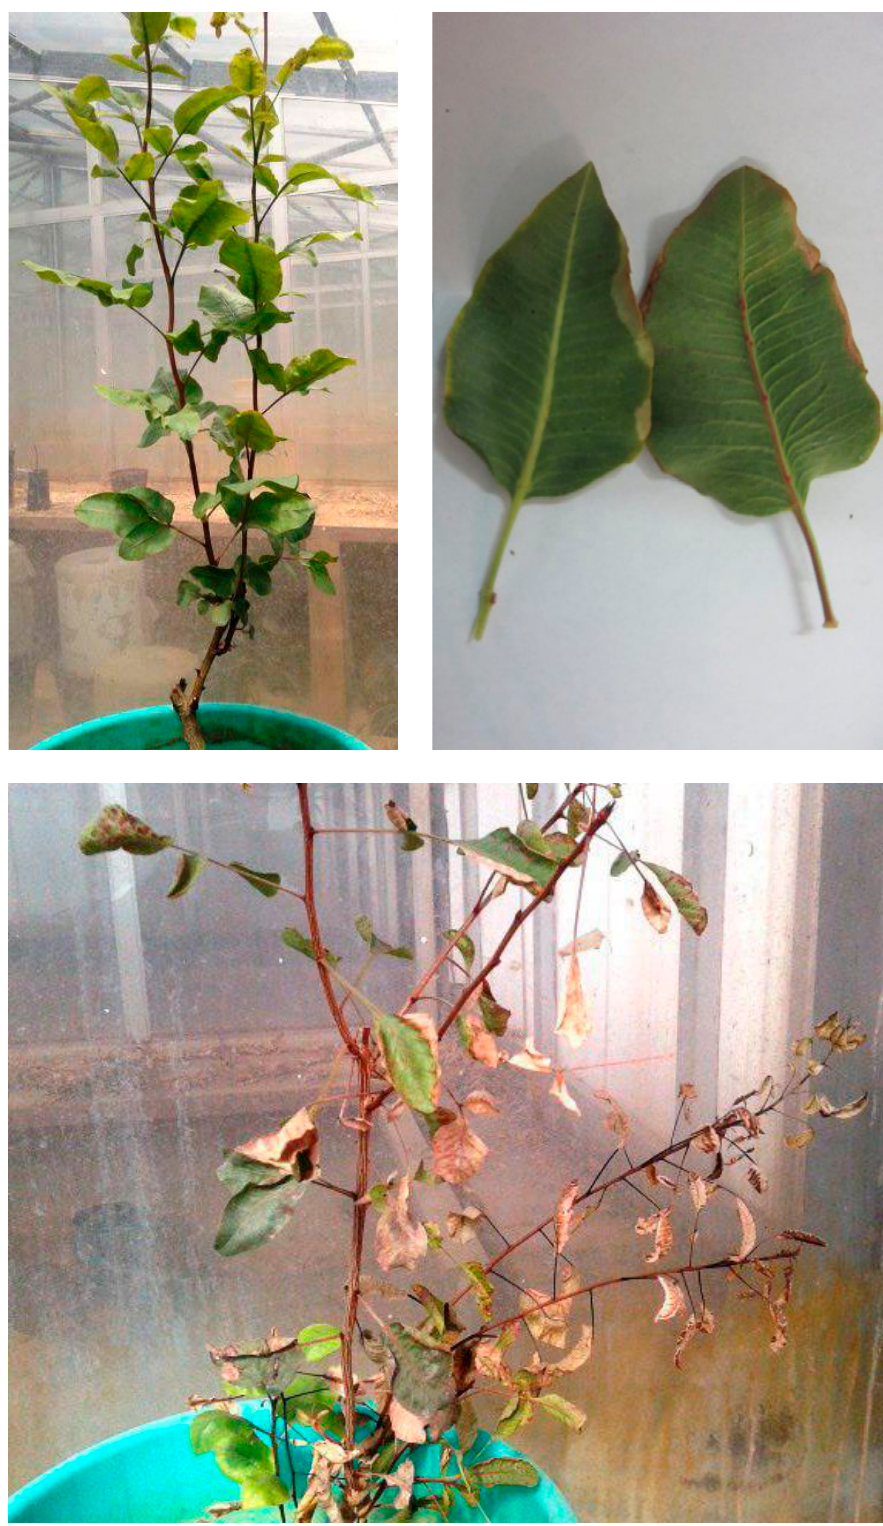
Figure 5. Pathogenicity tests: healthy plant of pistachio (uninoculated control, top left); initiation of pistachio leaf scorch symptoms 3 months after inoculation (top right); disease progress 1 year after inoculation under greenhouse condition